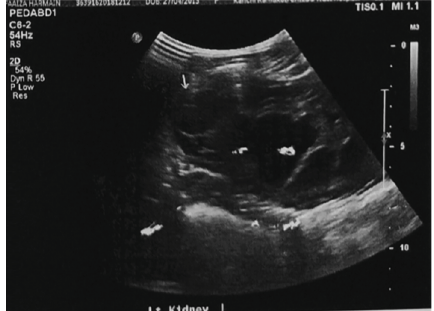
Figure 5: Day 5 post-JJ stenting ultrasound showing resolution of urinoma and decompression of the left